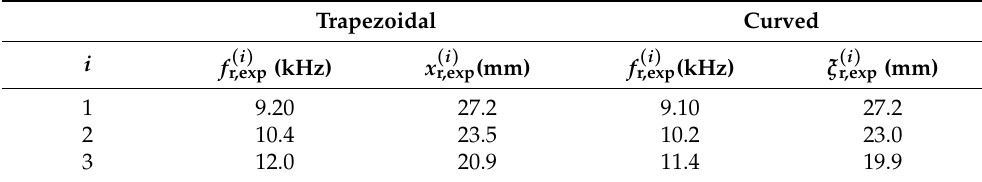
Table 2. Resonance frequencies f and curved prototype devices based on the experiment. The maximum deviation of f the trapezoidal and curved membrane devices is 5.26% and that between x Therefore, the oscillation characteristics of the trapezoidal and curved membrane devices fabricated in this study are in good agreement.